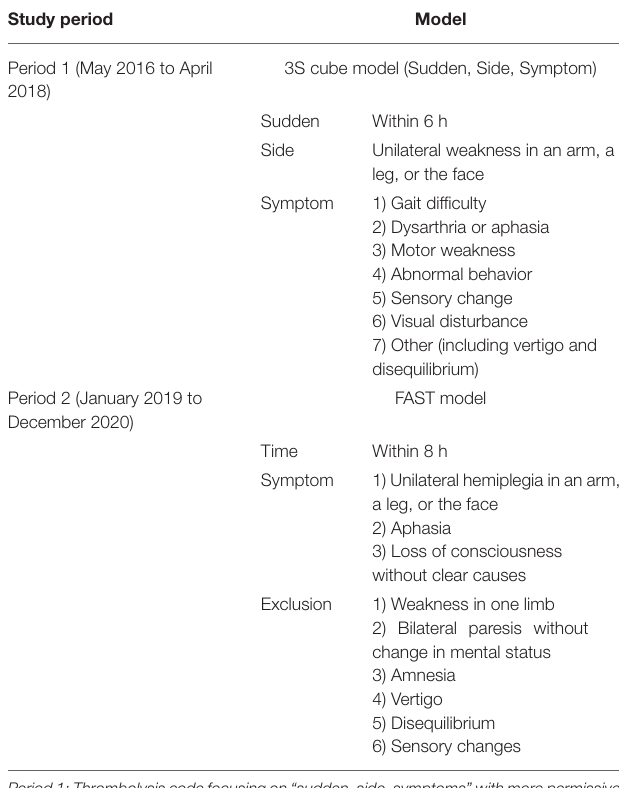
TABLE 1 | Thrombolysis code according to study